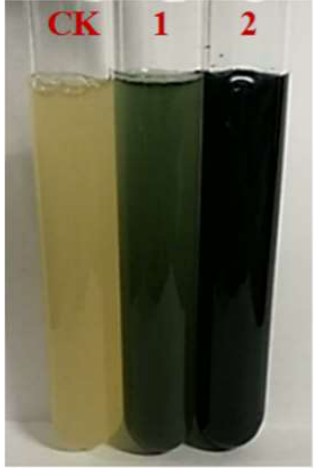
Figure 2. Indigo production from indole and tryptophan in E. coli AB fermentation. CK, E. coli DH5α; 1, E. coli AB fermentation with 160 μg/mL of indole; 2, E. coli AB fermentation with 1.0 mg/mL of tryptophan.